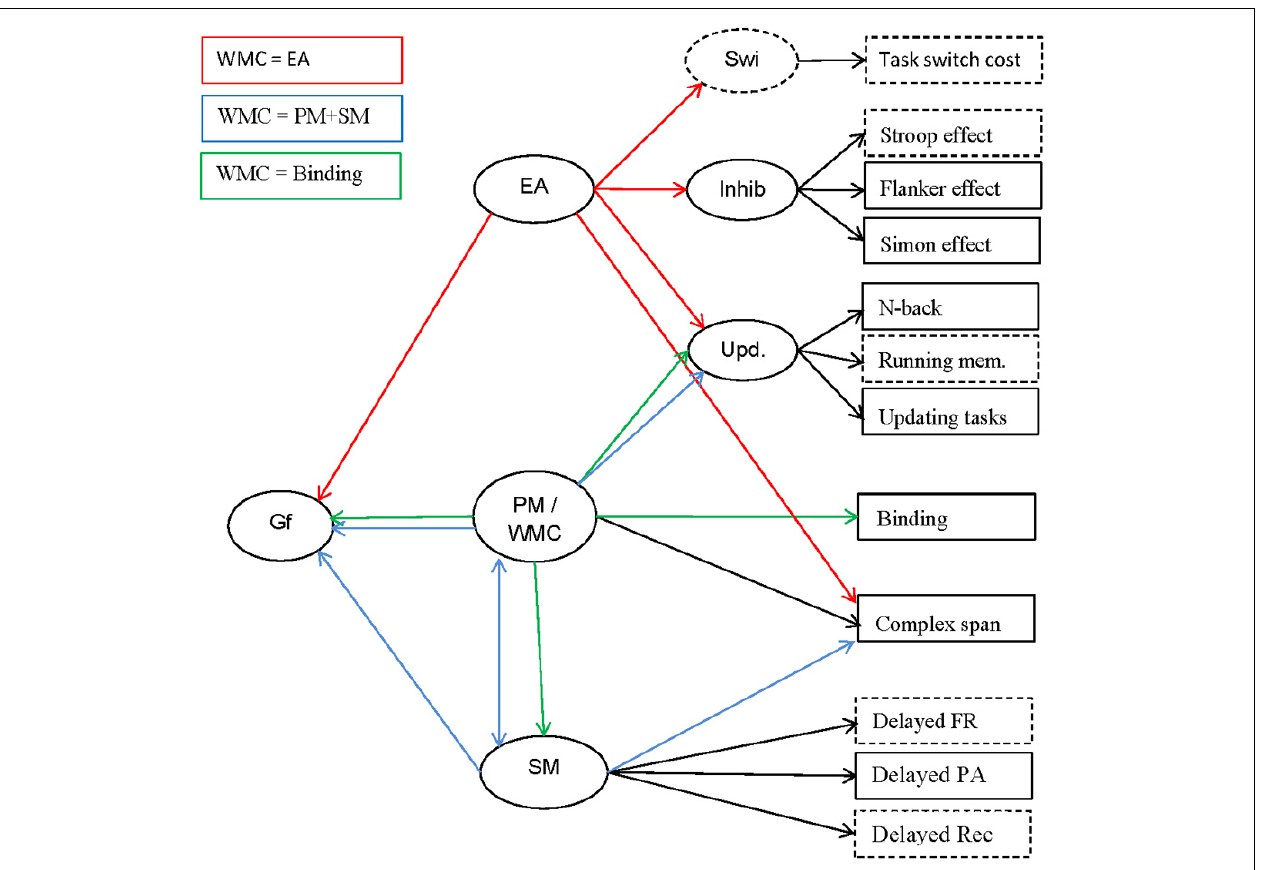
FIGURE 1 | Schematic outline of the constructs investigated (ovals), their indicators (rectangles), and their relations (arrows). The relations are color-coded (see legend in upper left corner) to indicate which relation is postulated by which of the three theories of WMC discussed in the text (relations drawn in black are theoretically non-controversial). Relations not coded in the color of a theory might be compatible with the theory in